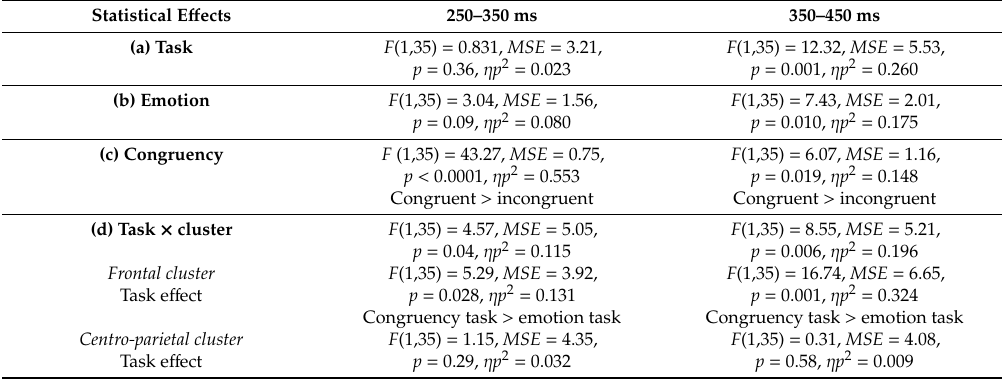
Table 3. Statistical results obtained for the analyses on mean amplitudes calculated over two time windows at two clusters (frontal and centro-parietal